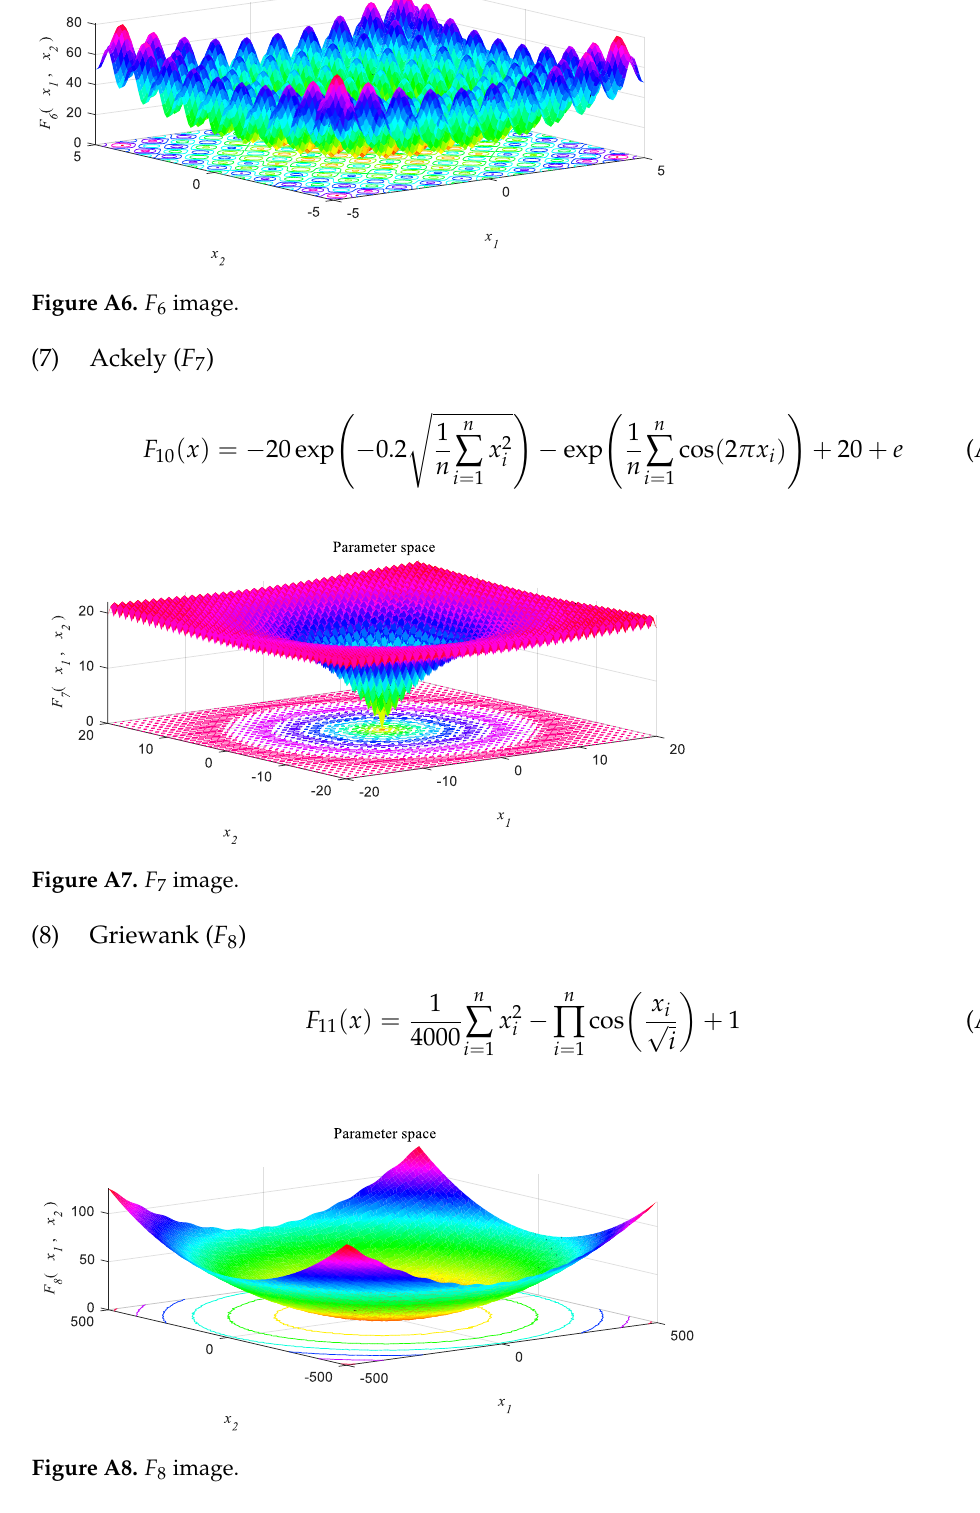
Figure A7. F 7 image.